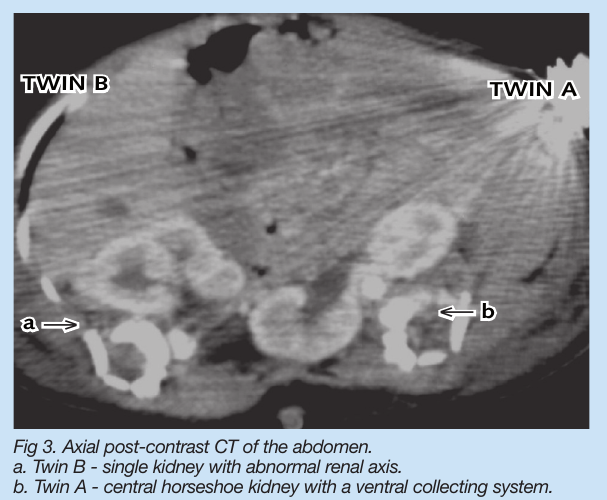
Fig 3. Axial post-contrast CT of the abdomen. a. Twin B - single kidney with abnormal renal axis. b. Twin A - central horseshoe kidney with a ventral collecting